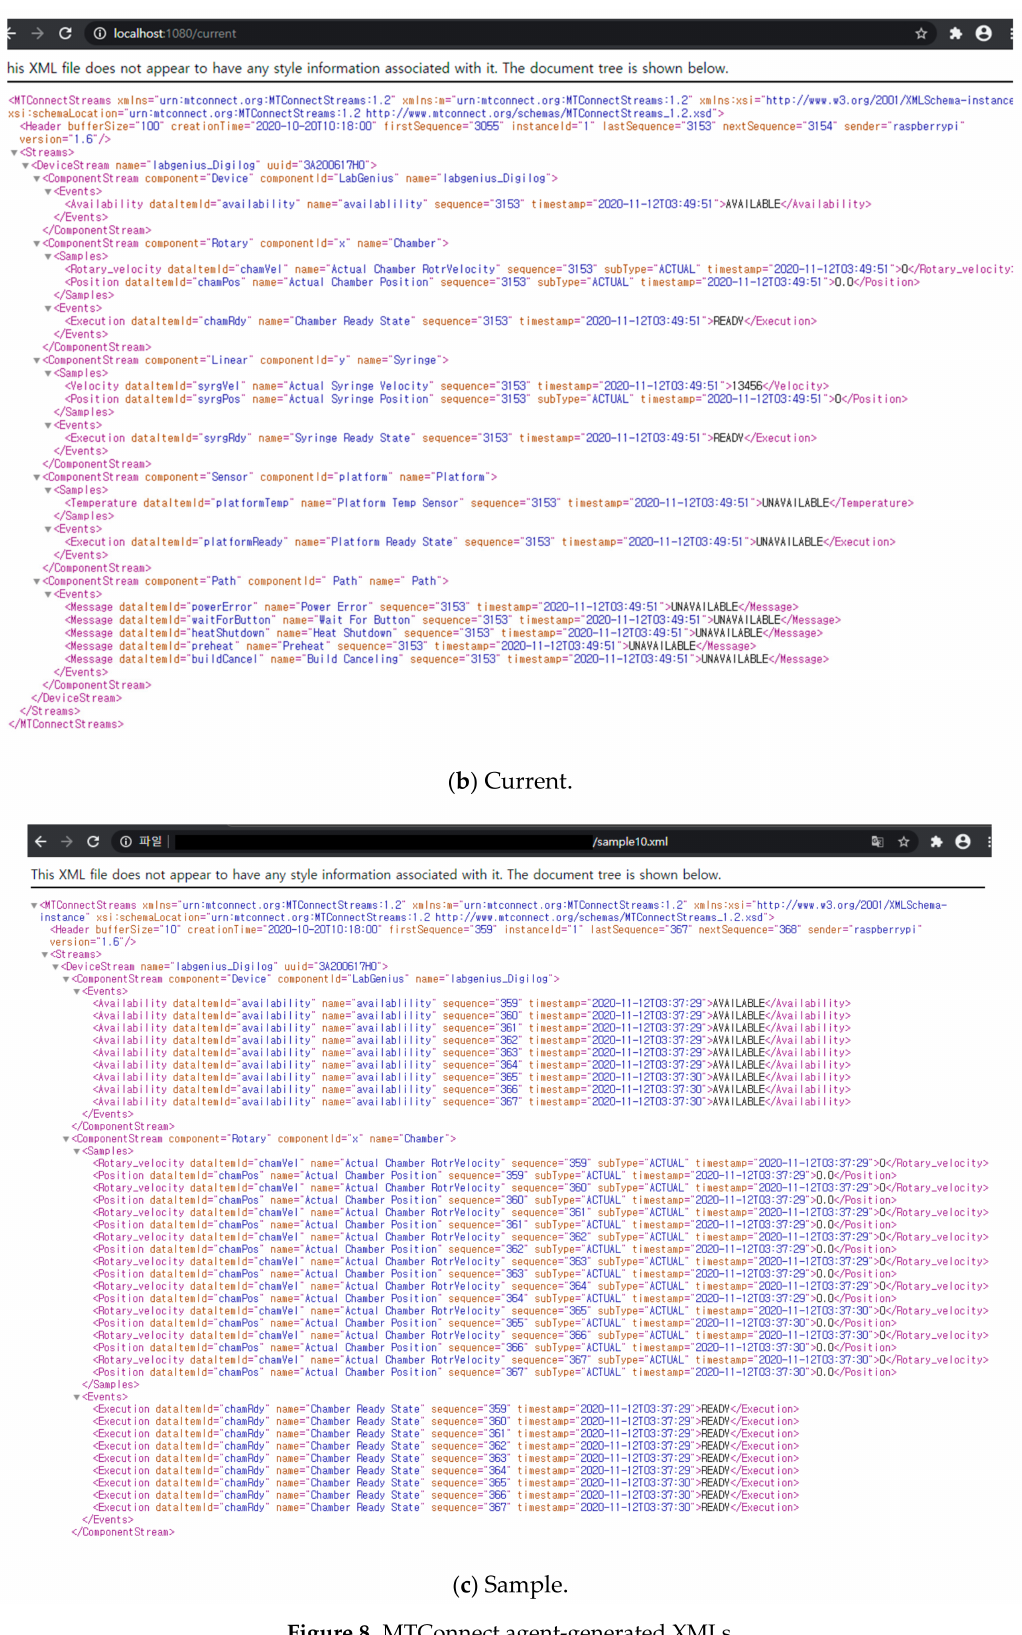
Figure 8. MTConnect agent-generated